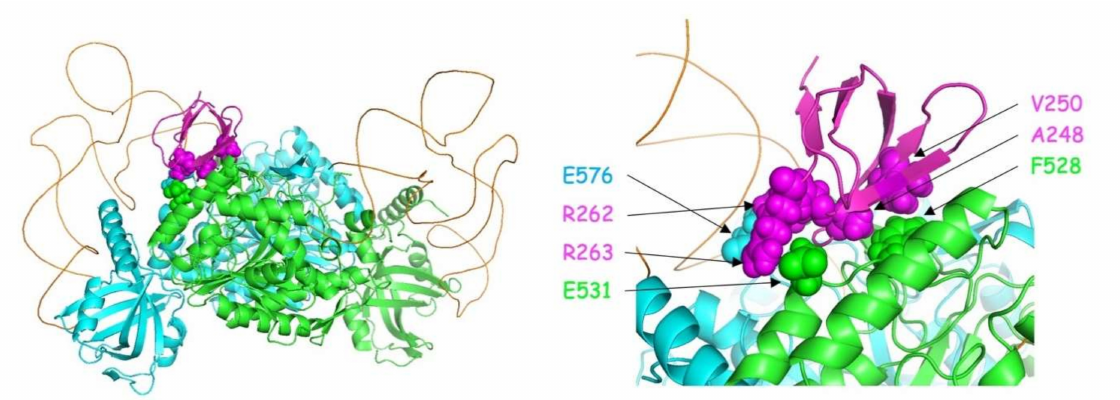
Figure 10. 3D model of the platform for association of IN-CTD with mLysRS. Left : The structural model shows a dimer of human LysRS in association with a monomer of the CTD of integrase from HIV-1. The two monomers of LysRS (3BJU) are in cyan and green, the two tRNA molecules in orange, the monomer of IN-CTD (5U1C) in magenta. The residues that build the platform for the assembly of the complex are represented by spheres. Docking of the two tRNA molecules was performed using the crystal structure of yeast aspartyl-tRNA synthetase complexed with two tRNA molecules (1ASY). Right : Zoom of the IN-CTD:LysRS interaction platform. Residues from the platform are labeled and colored according to the main